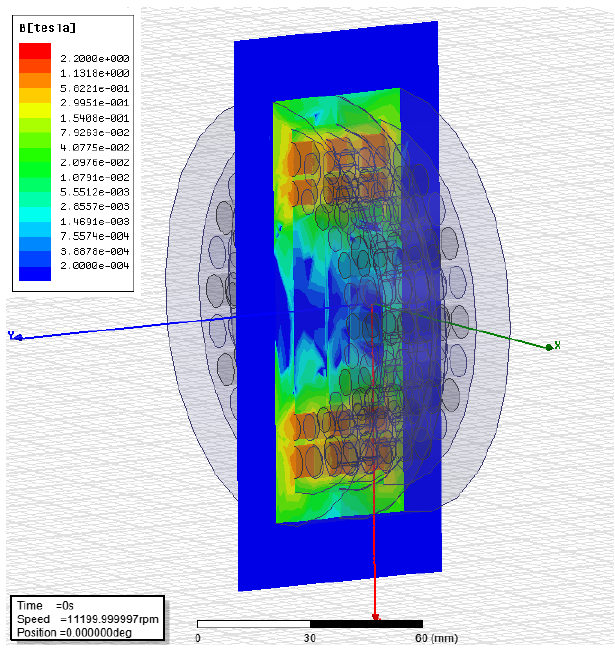
Figure 3. Magnetic field and main thermal implications in magnetic torque limiters.